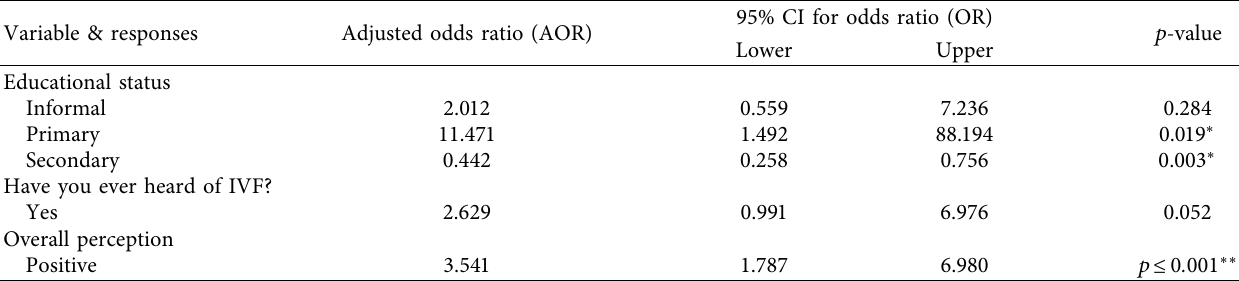
Table 10: Likelihood of participants’ preparedness to use IVF